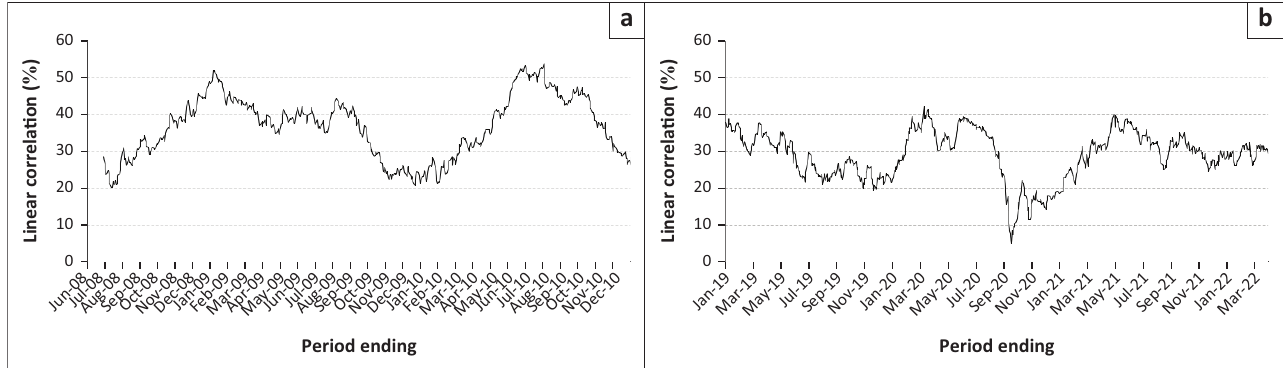
FIGURE 9: Pearson linear correlation between Sasol (SOL) and OIL over rolling 6-month periods from 2008 to 2010 covering the COVID-19 pandemic (a-b).